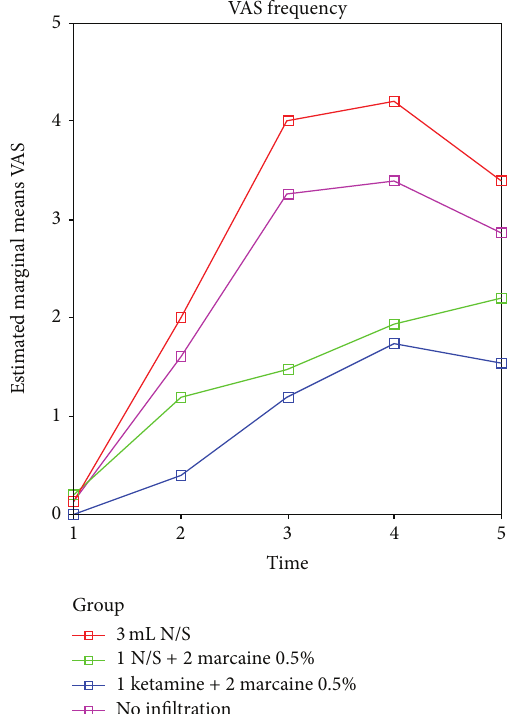
Figure 1: Level of pain at different times after surgery for separate groups. ANOVA test was used to compare groups. There was a significant difference in pain intensity between groups. Level of pain significantly increased and then decreased. There was an insignificant difference in pain intensity between groups 2 and 3. However, there was a significant difference between groups 2 and 3 and 1 and 4 ( 𝑃 < 0.001 ). Group 1 (3mL of normal saline), group 2 (1mL of normal saline plus 2mL of bupivacaine 0.5%), group 3 (1mL of ketamine plus 2 mL of bupivacaine 0.5%), and group 4 (no